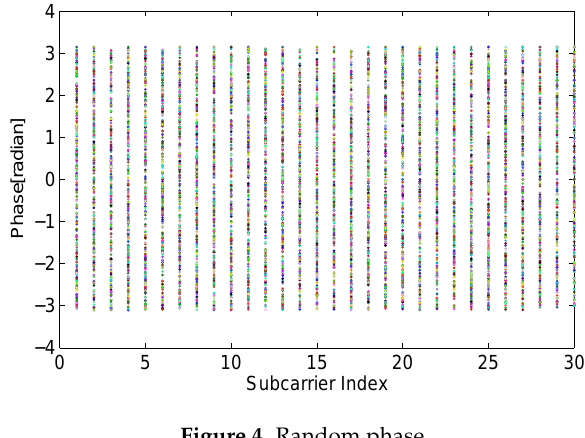
Figure 4. Random